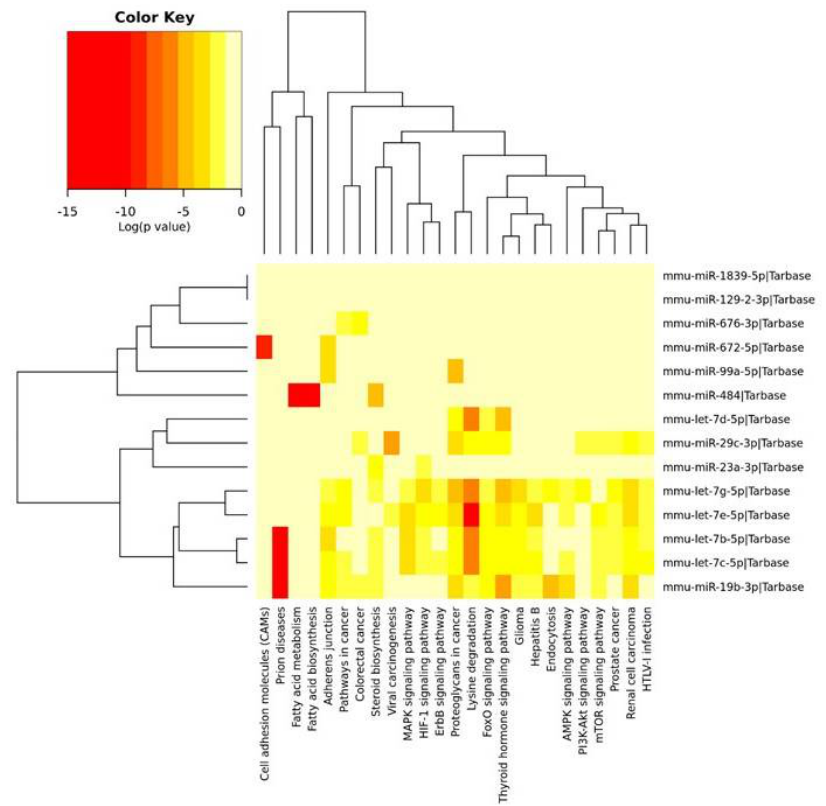
Figure 2. The heatmap indicating the associations of miRNAs with the KEGG pathways. The miRNAs are on the right-hand side, while the KEGG pathways are at the bottom of the map. The significances of linking miRNAs to the KEGG categories are color-coded (the scale in the upper-left corner).